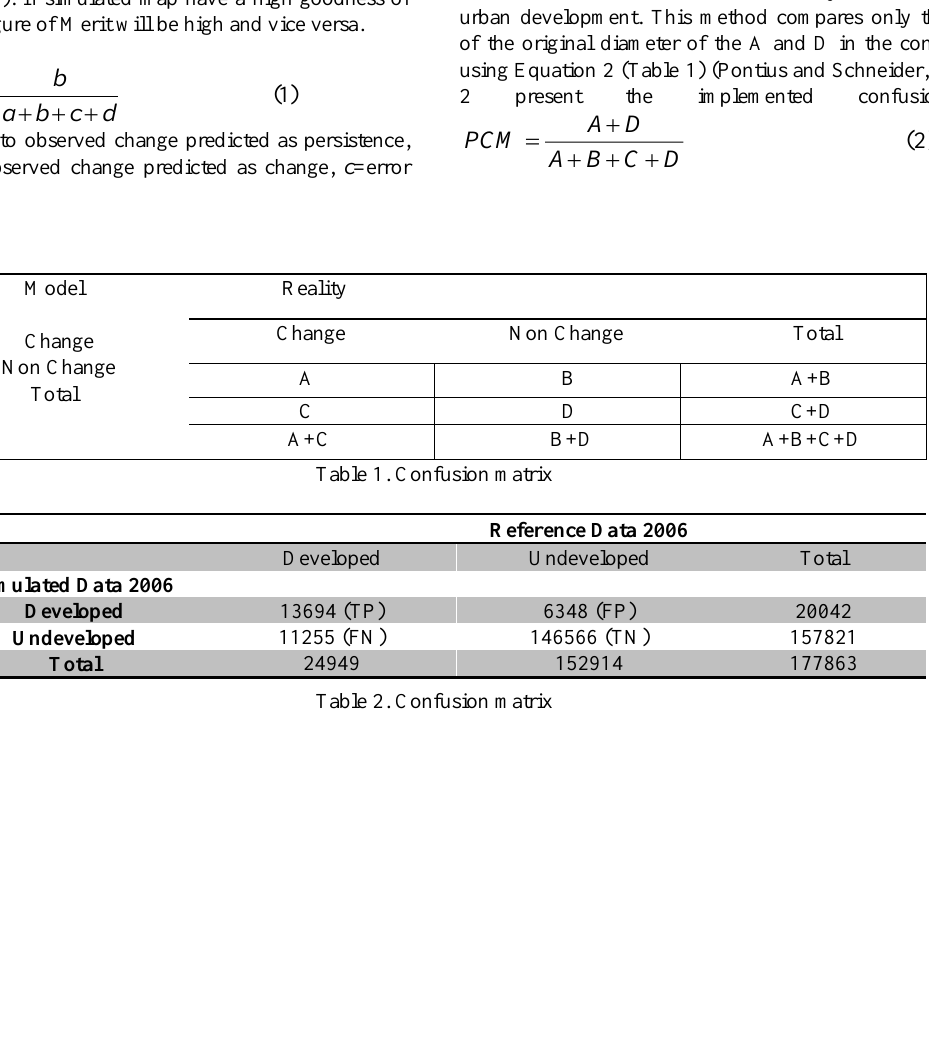
3.1 Figure of Merit (FoM)